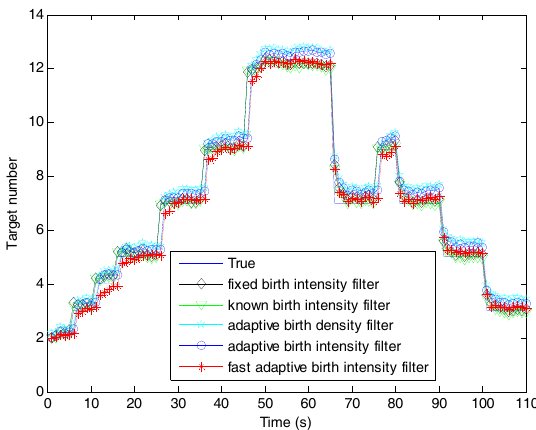
Figure 7. Target number estimation of the fast adaptive target birth intensity CBMeMBer filter and other CBMeMBer filters with different target birth models.